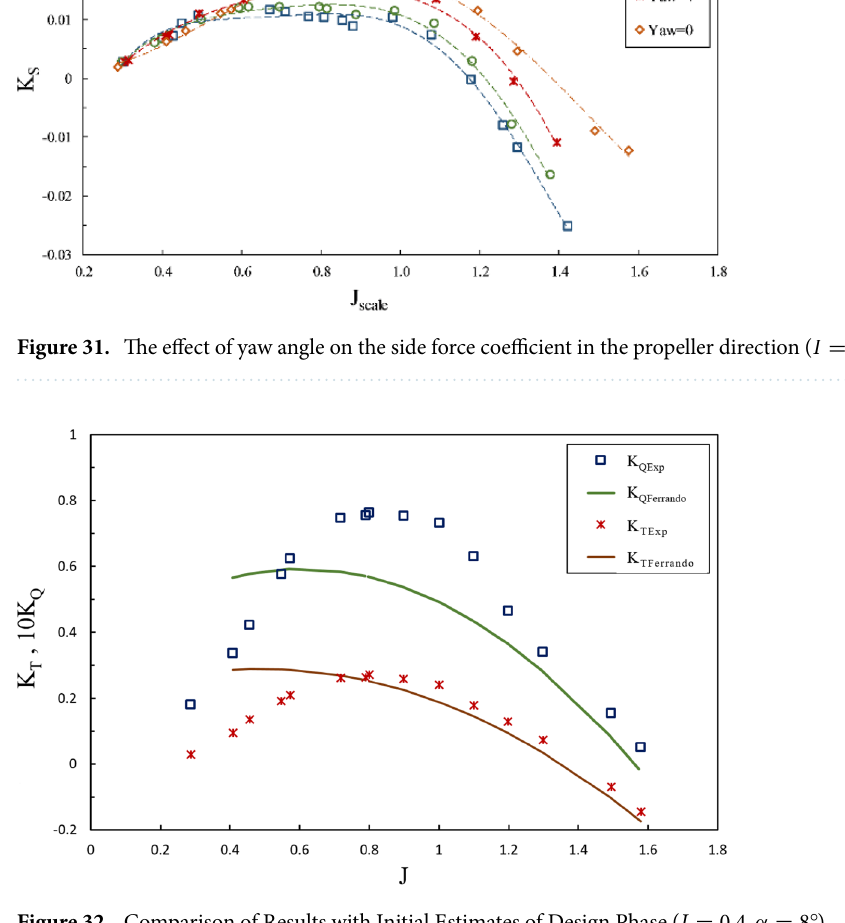
Figure 32. Comparison of Results with Initial Estimates of Design Phase ( I = 0.4, α = 8 ◦